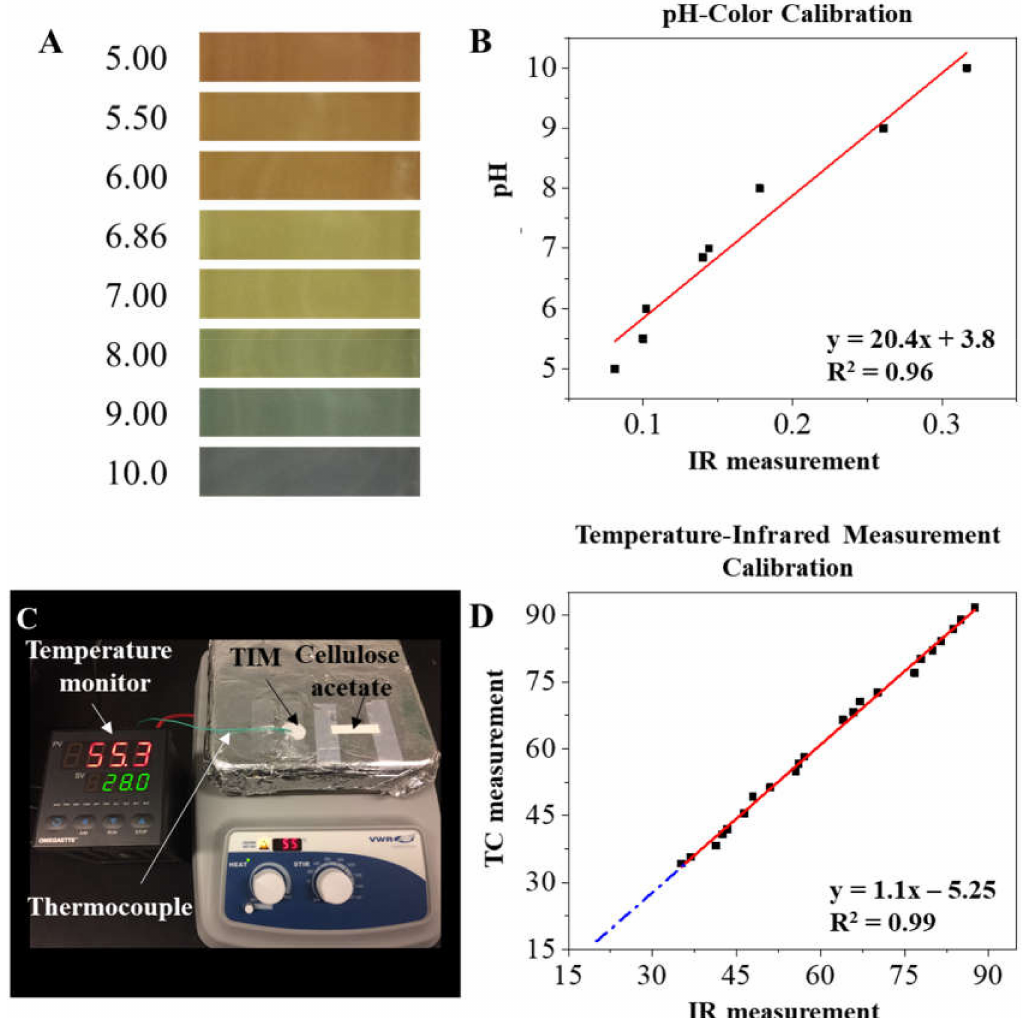
Figure 3. Calibration of pH and temperature-monitoring systems. ( A ) Images of the calibration system for monitoring pH change: CA paper with buffer containing pH indicator at given pH values (pH = 5 to pH = 10) were imaged. These imaged data were used to create the pH calibration curve demonstrated in ( B ). ( C ) Image of calibration system for temperature- change monitoring: CA paper is heated on the hot plate and the infrared temperature measurement is performed using images captured by the FLiR Studio software. The actual temperature is measured from the reading of a thermocouple (K-type) mounted to the hot plate. Infrared temperature measurements are calibrated to the thermocouple temperature measurements ( D